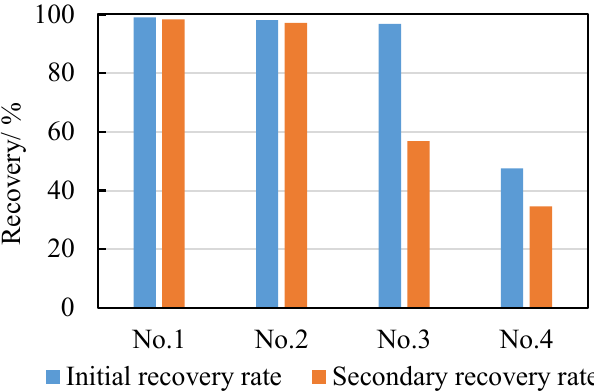
Figure 2. Results of the recovery comparison experiment.